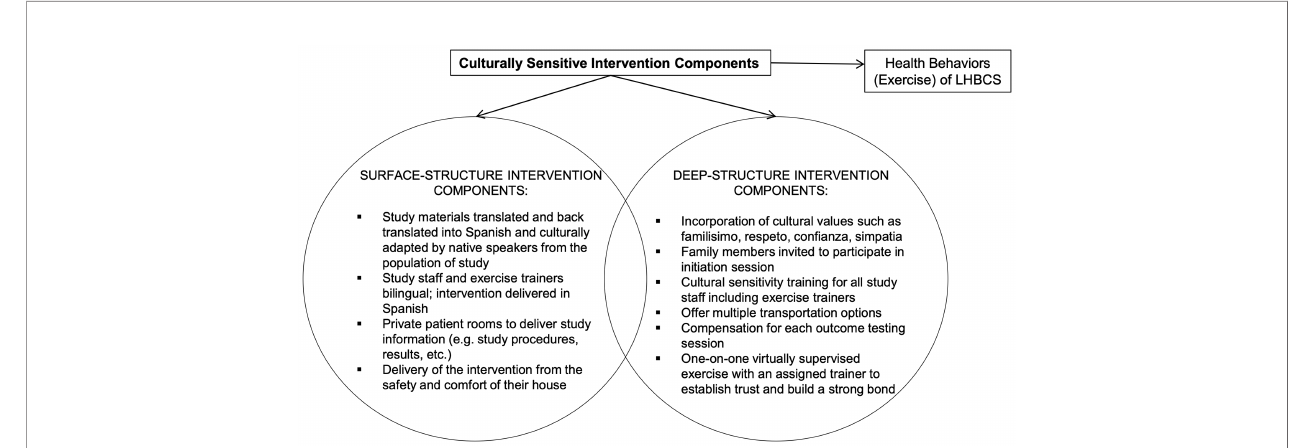
FIGURE 3 | Culturally sensitive components of the ROSA